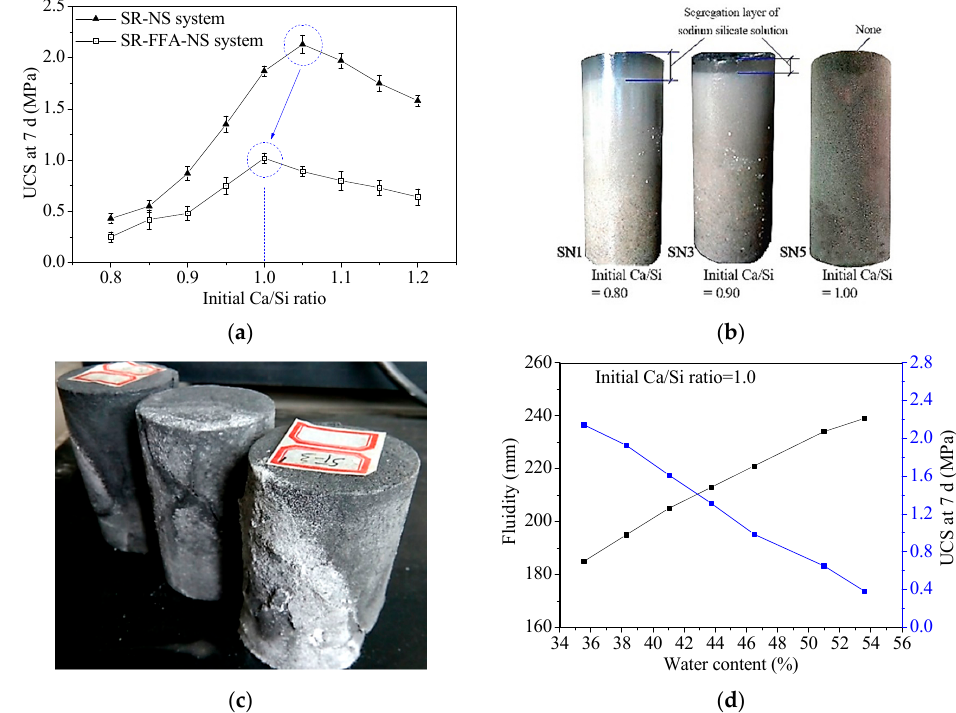
Figure 2. ( a ) Unconfined compressive strength (UCS) at 7 d, ( b ) solidification characteristics vs. Initial Ca/Si ratio for hardened pastes, ( c ) pan-alkali for hardened backfill paste, and ( d ) fluidity and UCS at 7 d vs. water